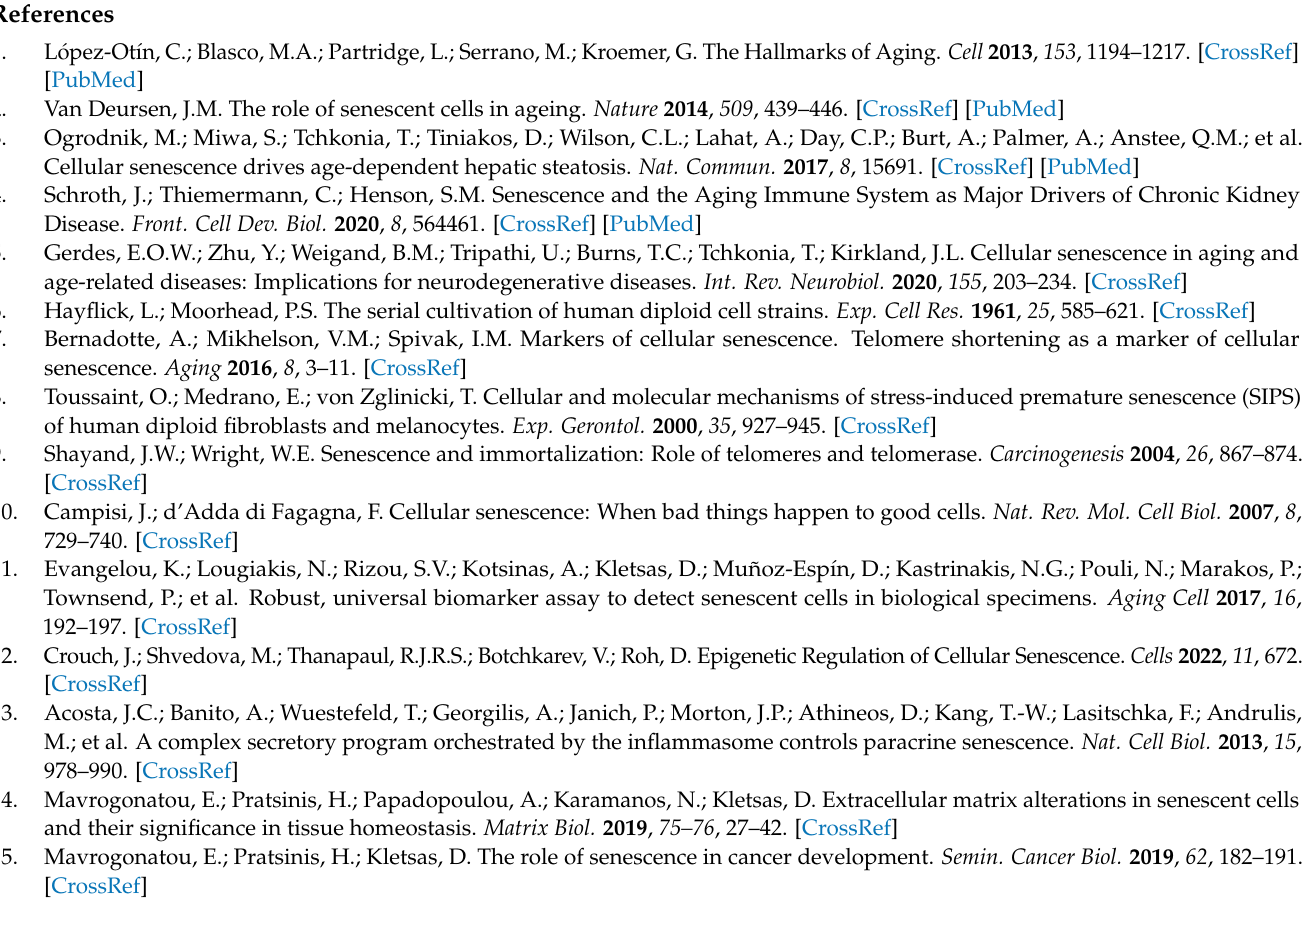
∆ β > 0.2 in Dox-SIPS hAd-MSC. Table S14. Results of pathway enrichment analysis for DSF after a middle number of passages, replicative senescence, irradiation- and doxorubicin-induced senescence. Table S15. Results of pathway enrichment analysis for hBM-MSC after a middle number of passages, replicative senescence, irradiation- and doxorubicin-induced senescence. Table S16. Results of path- way enrichment analysis for hAd-MSC after a middle number of passages, replicative senescence, irradiation- and doxorubicin-induced senescence. Table S17. Summary of DMP sets used in cluster analysis. Figure S1 Gene overlaps among the three types of senescence in (a) DSF, (b) hBM-MSC and (c)